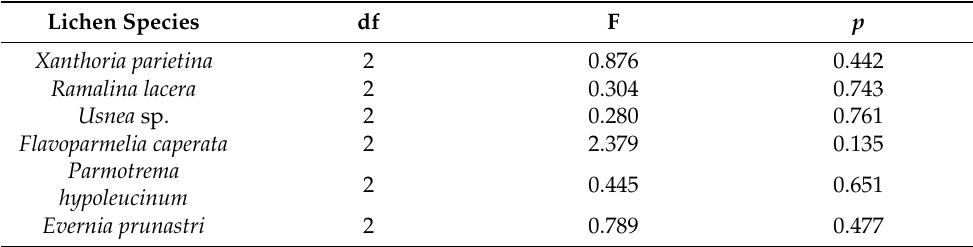
Figure 2. Recovery capacity for all studied lichens computed as the difference between Fv/Fm ratio at the end of the experiment (day 58) and Fv/Fm ratio at the end of the direct sunlight exposure (day 29) for the control (no nitrogen [N] addition), 25 N (treated with 25 mM of (NH 4 ) 2 SO 4 ), and 50 N (treated with 50 mM of (NH 4 ) 2 SO 4 ). No significant differences among N treatments were found for any species ( n = 5). Table 4. One-way ANOVA of the Fv/Fm evolution following the recovery period for all the studied epiphytic lichens.